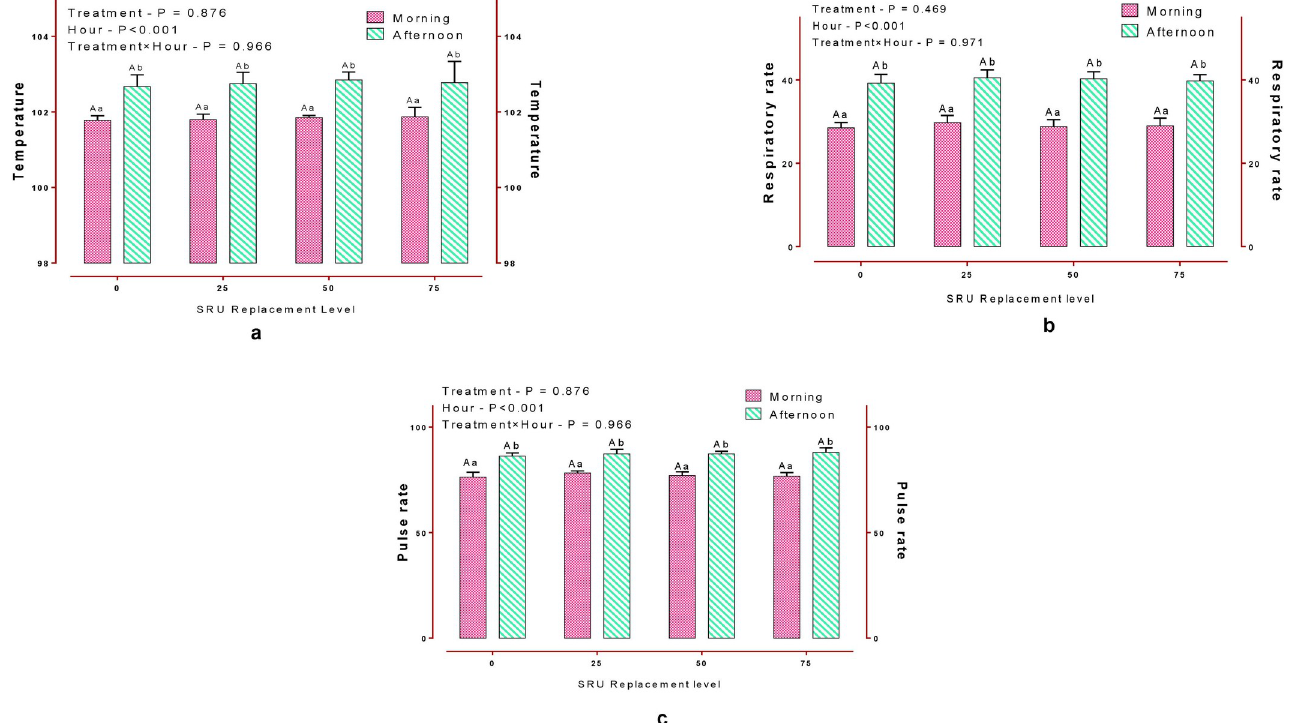
Fig 2. a, b, c Temperature, Respiratory rate, and Pulse rate in sheep during the two periods (Morning Vs. Afternoon). Means bearing different superscripts (A, B) differ significantly (P > 0.05) within the same group at different periods and (a, b) between groups in same (P < 0.01)